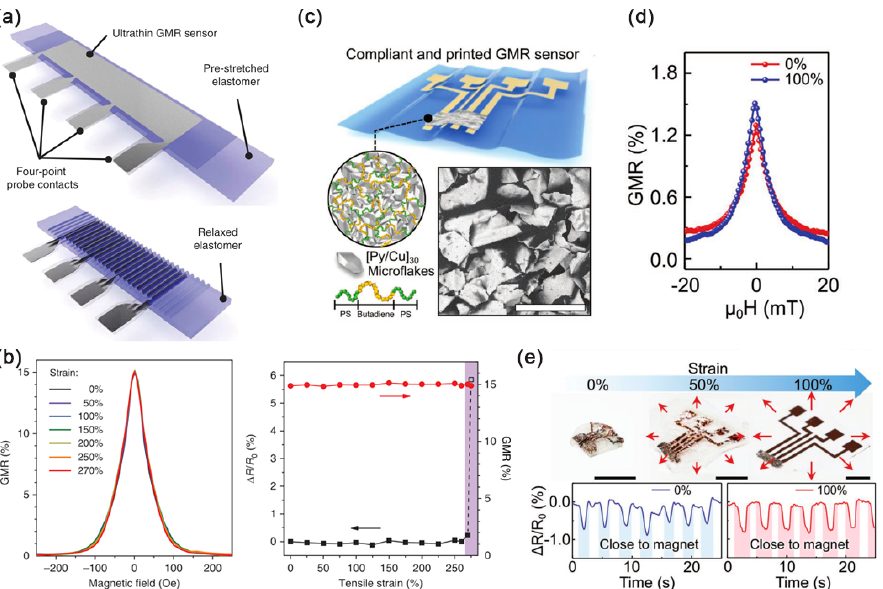
Figure 8. ( a ) Schematics of stretchable GMR sensors; ( b ) Stretching experiments results of the stretchable GMR sensor. Adapted with permission from Ref. [66] and licensed under CC BY 4.0. Copyright 2015, copyright Springer Nature Limited. ( c ) Schematics of printed GMR sensors; ( d ) GMR performance of the printed sensor in the relaxed and stretched state; ( e ) Photograph of a printed GMR sensor from 100% of stretching to 0% of relaxed state. Adapted with permission from Ref.